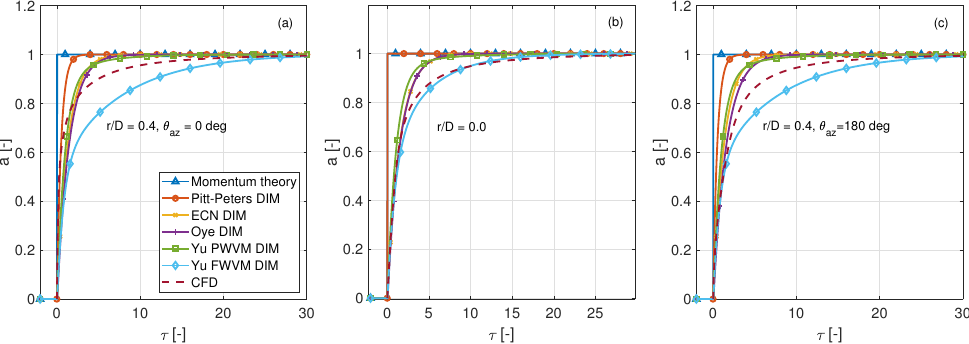
Figure 6. Normalized induction factor a n , norm at different positions when base C T = 0.6, step ∆ C Φ y = 30 deg, ( a ) downwind part: r/D = 0.4, θ az = 0 ( b ) center part: r/D = 0 ( c ) upwind T = +0.1, part: r/D =